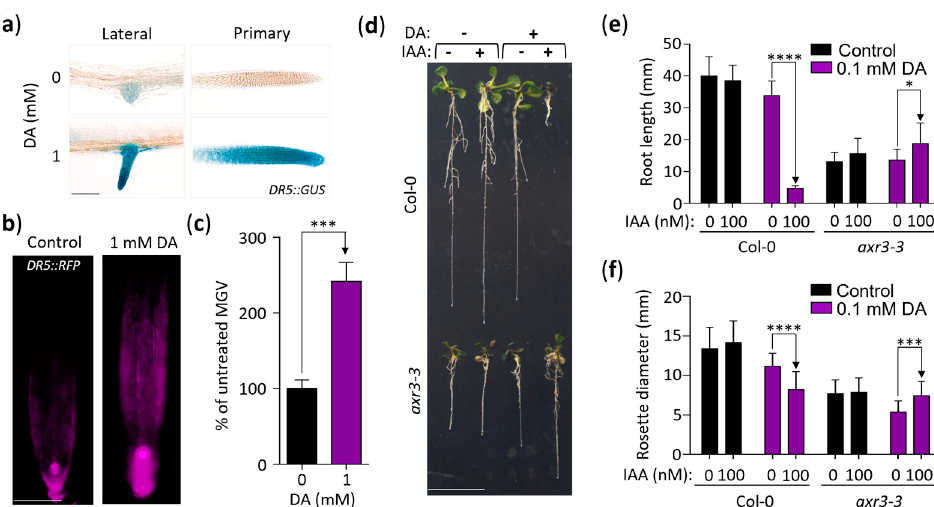
Figure 3. DA enhances auxin activity in roots and shoots. ( a ) DR5::GUS expression is higher in the root tips of seedlings grown on DA-supplemented media. Seedlings grown for 7 days on control and 1 mM DA-supplemented MS/2 media were immersed in a buffer containing 1 mg/mL of X-Gluc, were cleared in 100% ethanol, and were rehydrated in 50% glycerol. Micrographs were taken at 20× magnification. Scale: 100 µm. ( b ) DR5::RFP expression confirms that DA alters auxin activity in roots. DR5::RFP seedlings were grown as in ( a ), and RFP signal was captured using fluorescence microscopy. Scale: 100 µm. ( c ) Quantification of DA-induced DR5::RFP expression in root tips shown in ( b ). Mean grey value (MGV) of root tips was measured up to 600 µm from the root cap. Data are presented as percent change in MGV ± SEM ( n ≥ 6). *** represents p < 0.001 (one-way ANOVA with Dunnett’s post-test; comparisons are labeled with one-way arrows). ( d ) Auxin-insensitive plants resist DA-induced IAA hypersensitivity. Col-0 and axr3-3 seedlings were grown vertically on media with or without 100 µ M DA and 100 nM IAA for 11 days. Representative seedlings were transferred to a fresh plate and were photographed. Scale bar: 10 mm. ( e , f ) The impact of DA-induced IAA hypersensitivity on primary root growth and rosette size. Plants were grown as in ( d ) and were photographed, and root length and rosette diameter were measured using ImageJ software. Data are presented as mean ± SD ( n ≥ 16; * represents p < 0.05; *** represents p < 0.001; **** represents p < 0.0001; one-way ANOVA with Tukey’s post-test; multiple comparisons are denoted by one-way